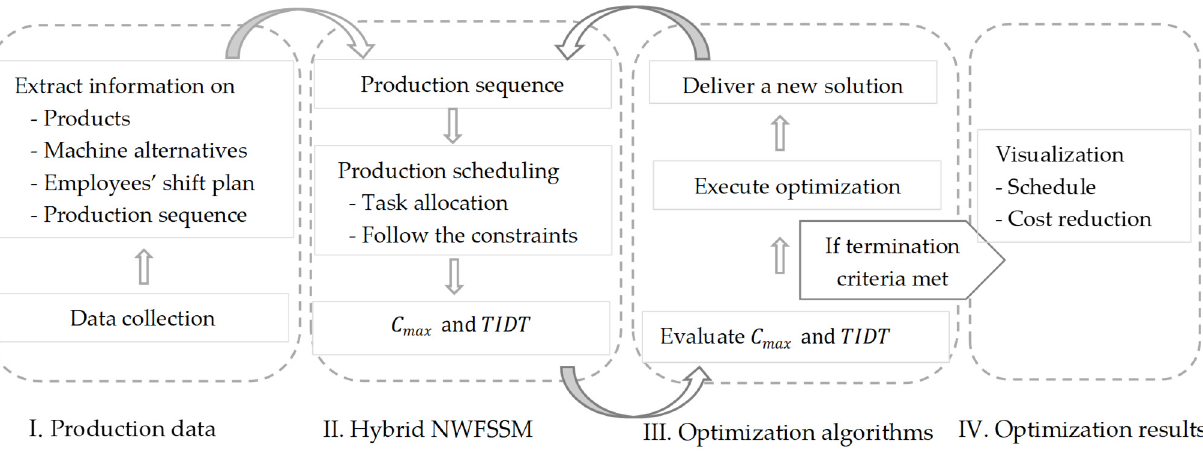
Figure 2. Working principle of bakery production optimization using hybrid no-wait flowshop scheduling model (NWFSSM).